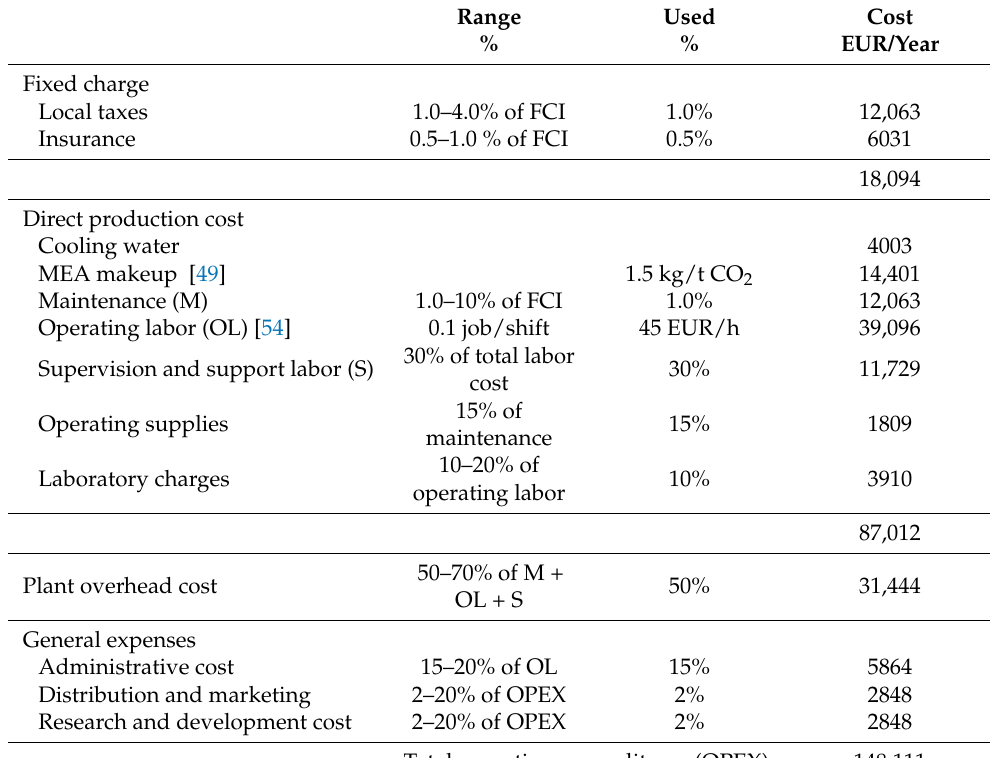
Table 9. Total operating expenditures (OPEX) for MEA CO 2 separation plant. Ranges are from [53], others are